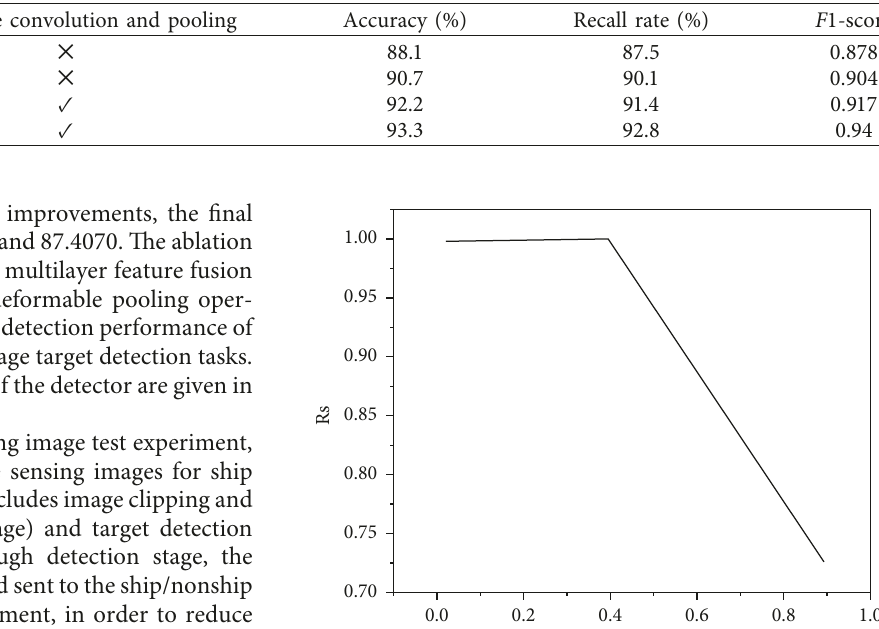
Table 12: Experimental results of the detector proposed in this study.